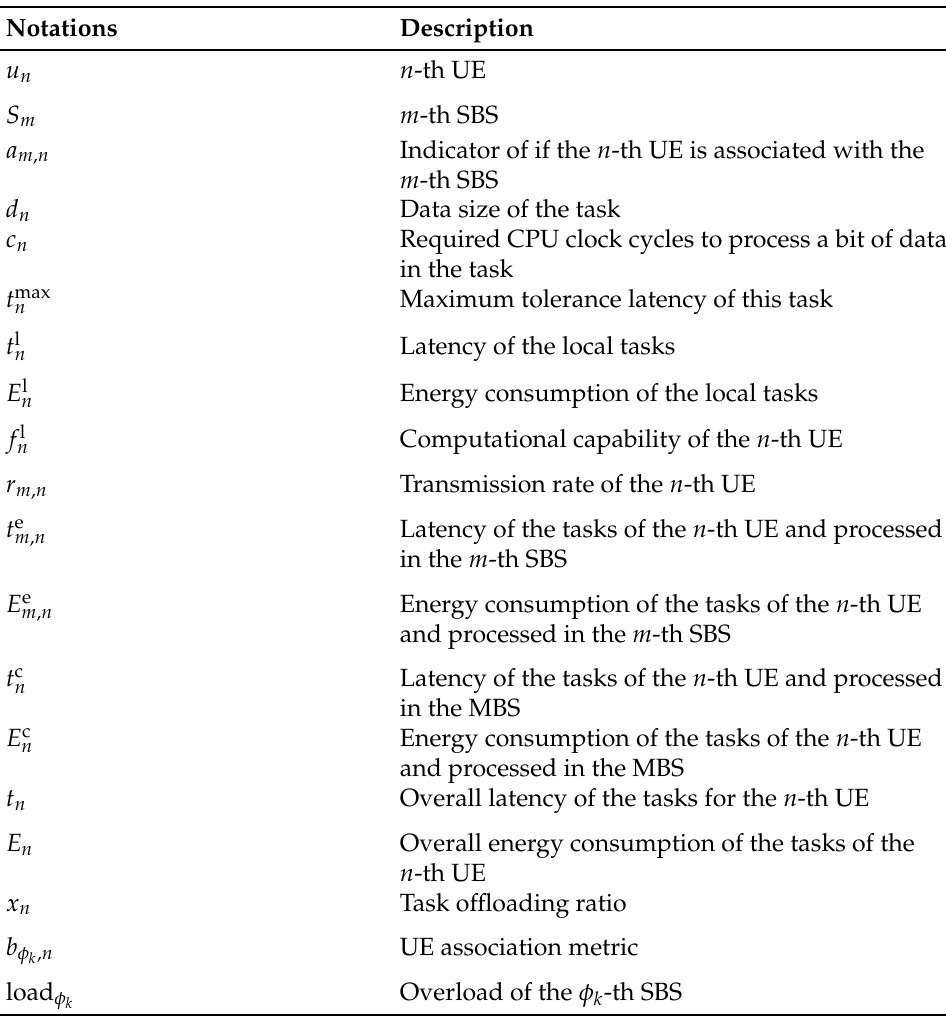
Table 1. Notations in this